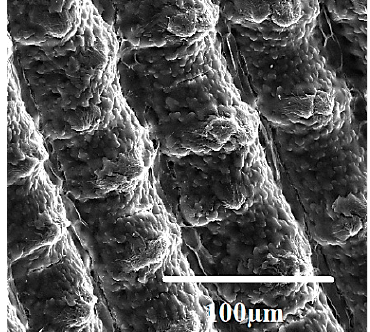
Figure 11. Equilibrium curves for sorption of Congo red onto ( a ) S20_70/30 and ( b ) ERH.